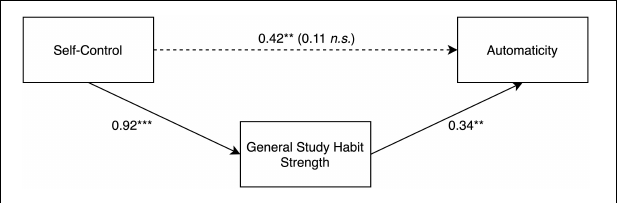
FIGURE 2 | Person level mediation analysis with unstandardized regression coefficients of the effect of self-control on automaticity through general study habit strength. The first coefficient on the path from self-control to automaticity represents the total effect without the mediator; the coefficient in parentheses on this path represents the direct effect with the mediator included in the model. ** p < 0.01. *** p < 0.001.